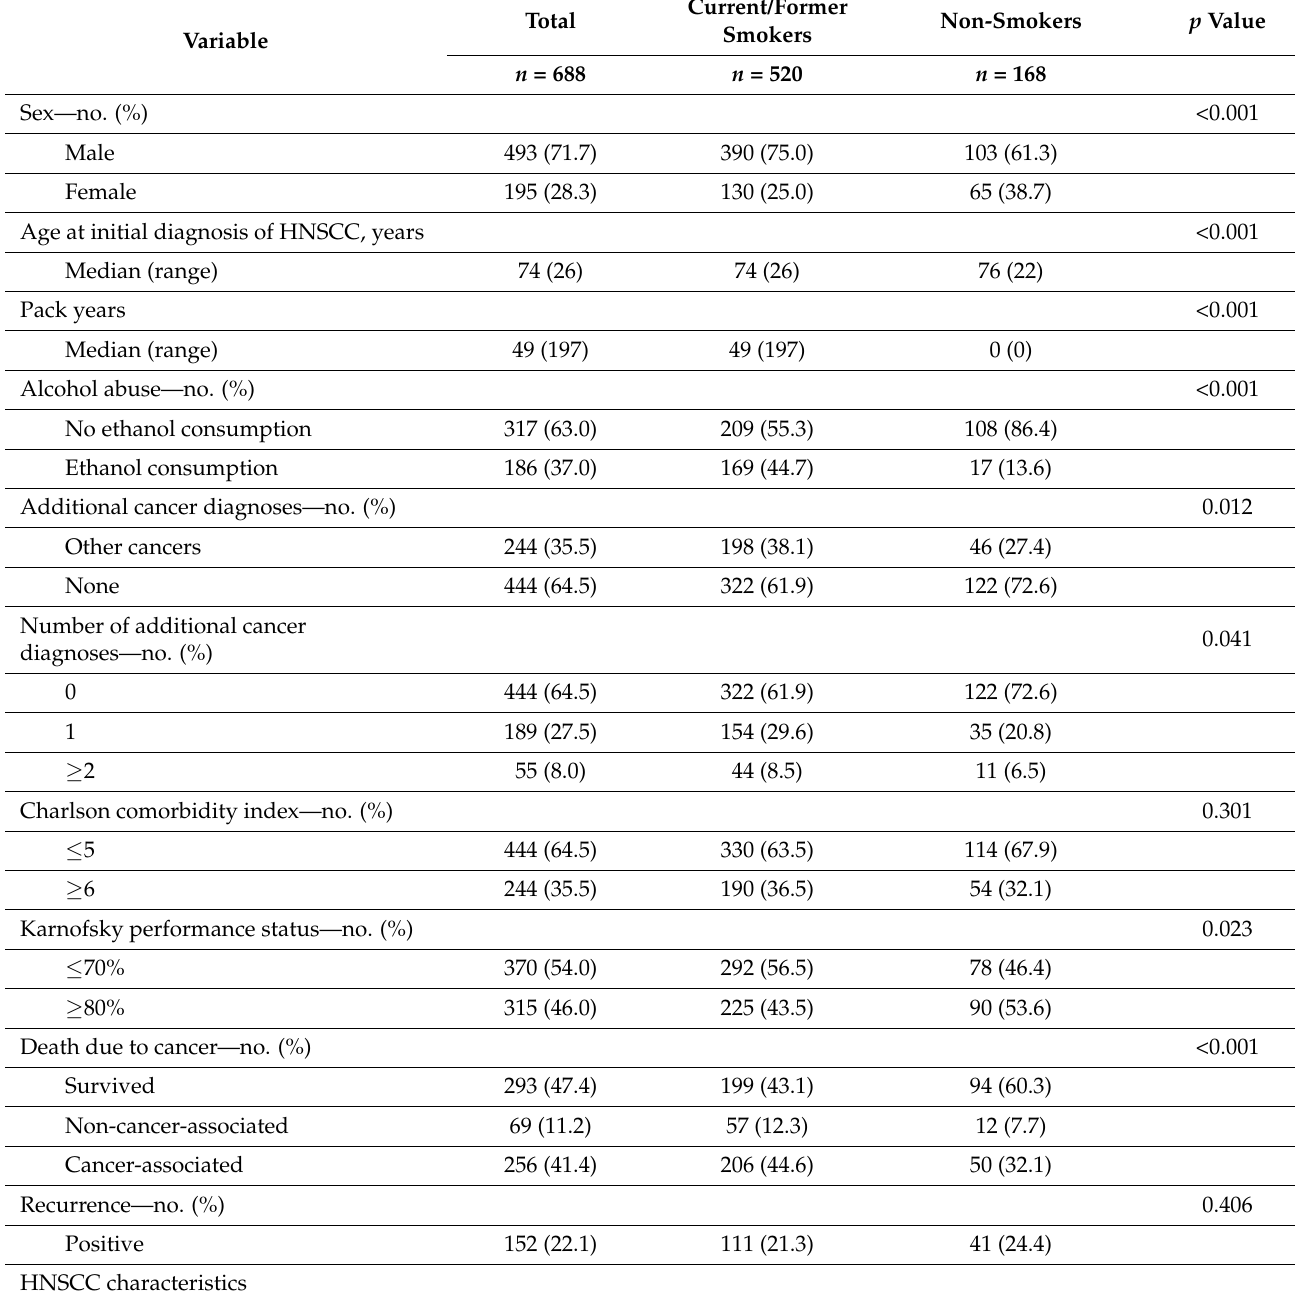
Table 1. Patient and tumour characteristics of the study population according to their smoking